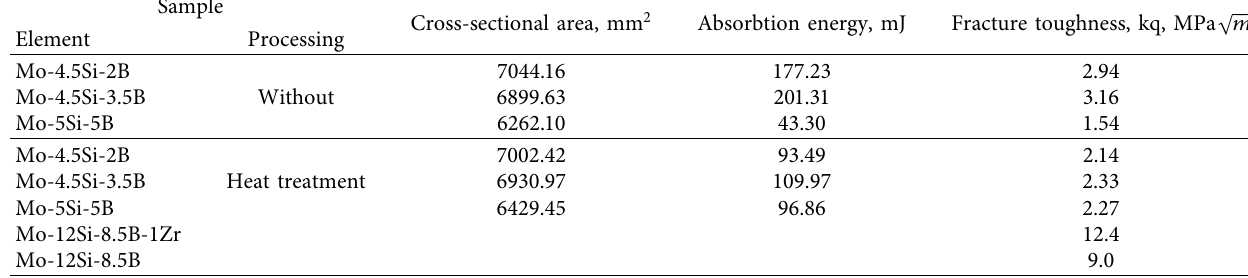
Table 6: Fracture toughness of samples with different compositions.